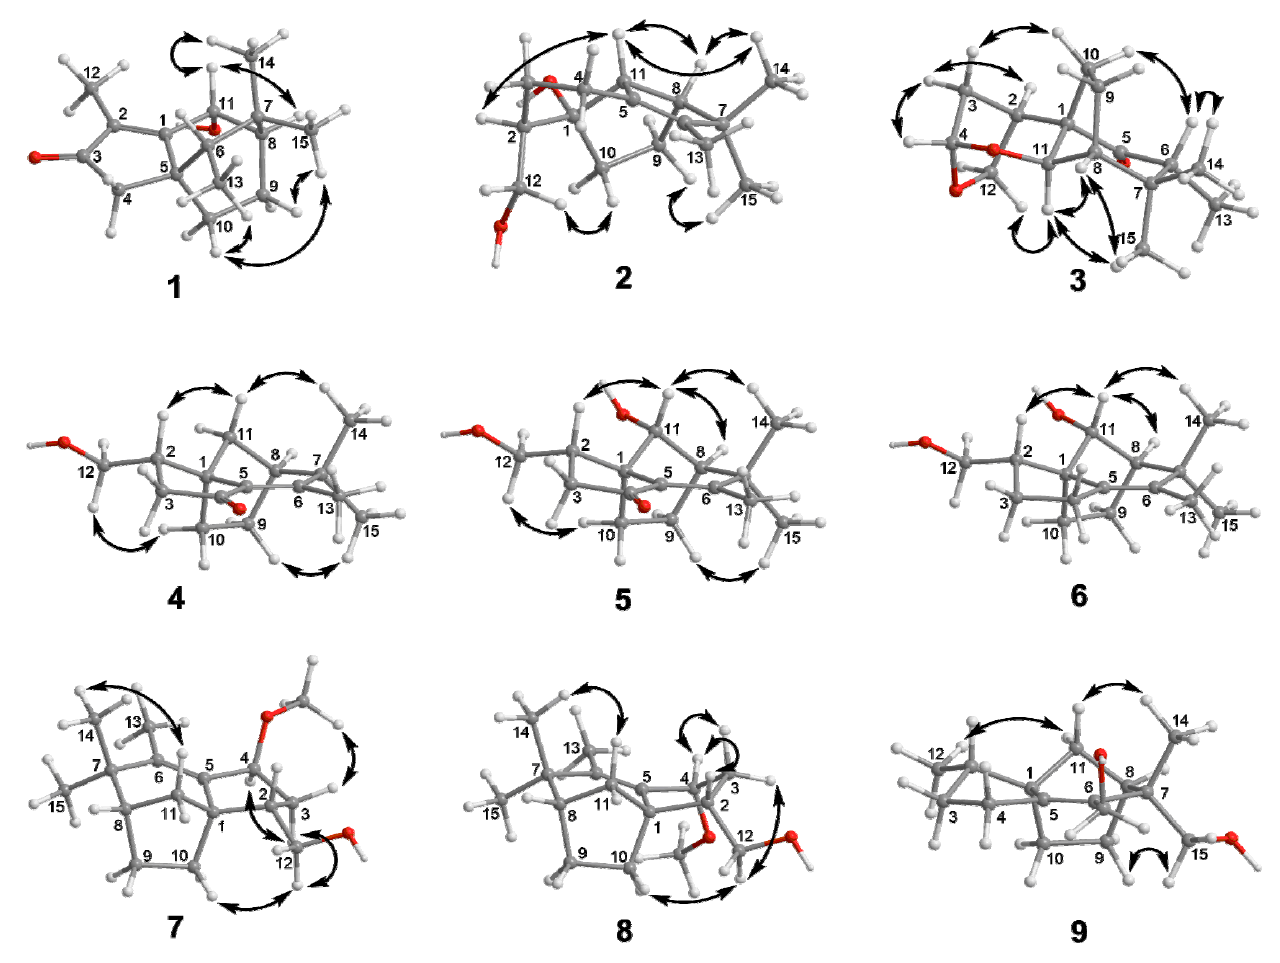
Figure 3. Key NOE correlations of compounds 1 – 9 .